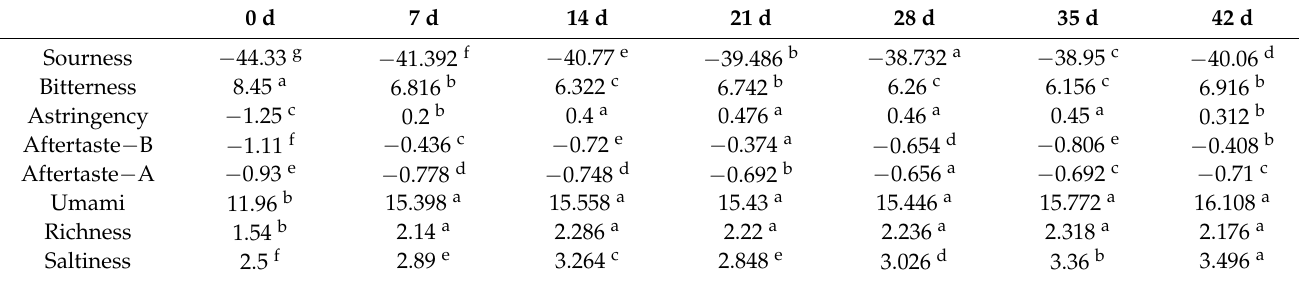
Figure 2. Taste value ( A ) and PCA analysis ( B ) of E- tongue at different fermentation times. PCA is expressed as the mean of flavor values. Table 2. Taste value of E- tongue under different fermentation